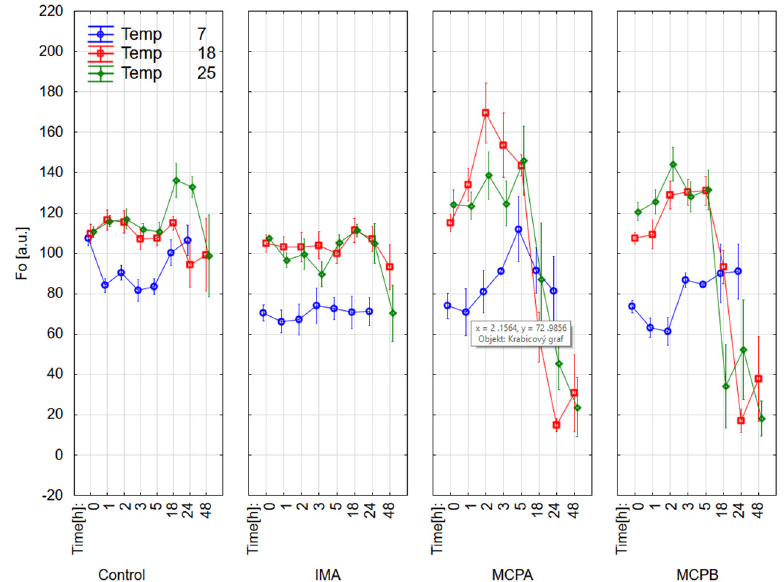
Figure 1. Background chlorophyll fluorescence (F 0 ) as affected by MCPA, MCPB and IMA in G. orientalis cultivated at three different temperatures (7, 18 and 25 °C). Data points represent means of five replicates ± standard deviation. The replicates were five leaves, each on a different plant. The data related to the measurements taken after 48 h of exposition at 7 °C are missing because of a fatal error during the downloading of the data from a FluorPen instrument (data lost).